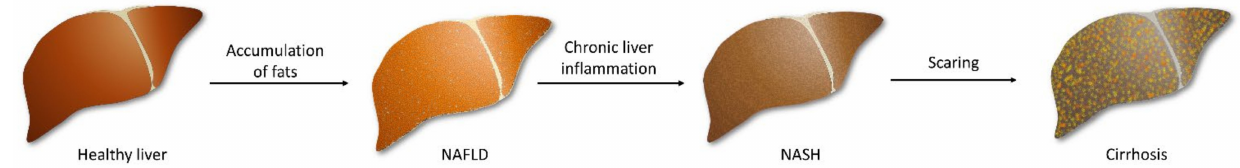
Figure 1. The development of fatty liver beginning with the accumulation of fats in primarily healthy hepatocytes. Prolonged inflammation in the fatty liver leads to steatosis and fibrosis of tissue. The following scaring of the liver triggers irreversible damage, and cirrhosis